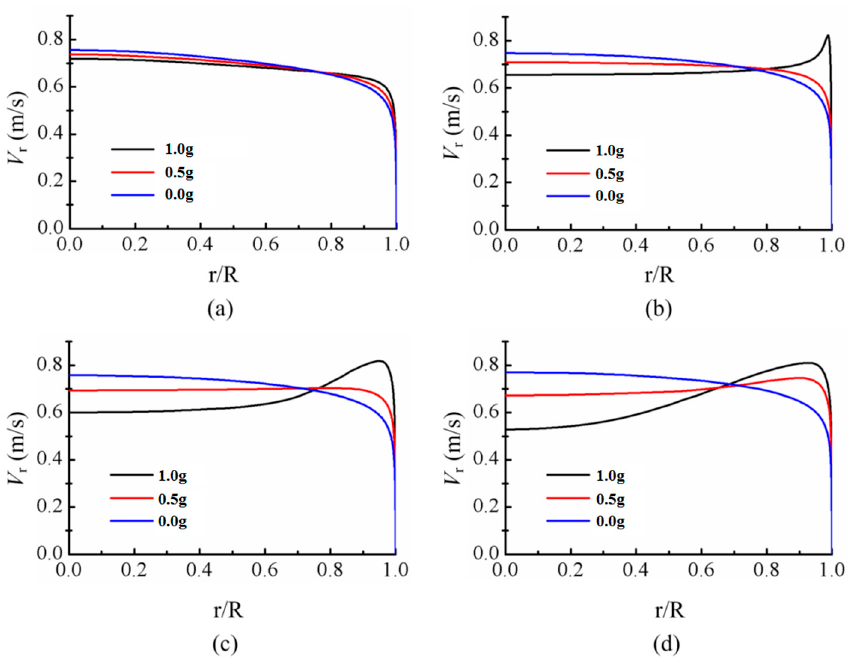
Figure 24. Distribution of the velocity in different sections: ( a ) x/D = 13; ( b ) x/D = 26; ( c ) x/D = 39; ( d ) x/D = 53.